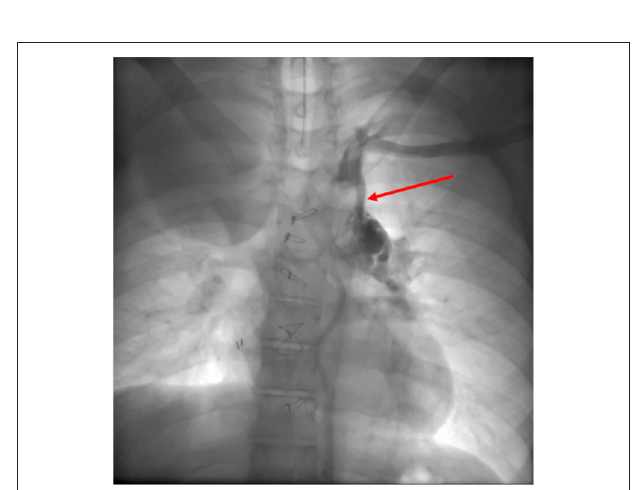
FIGURE 9 | Veno-venous collateral vessel seen by Cardiac Catheterization. After injection in the left arm a large vessel (red arrow) arising from the left brachiocephalic venous system is visualized. The vessel courses inferiorly connecting to the left pulmonary